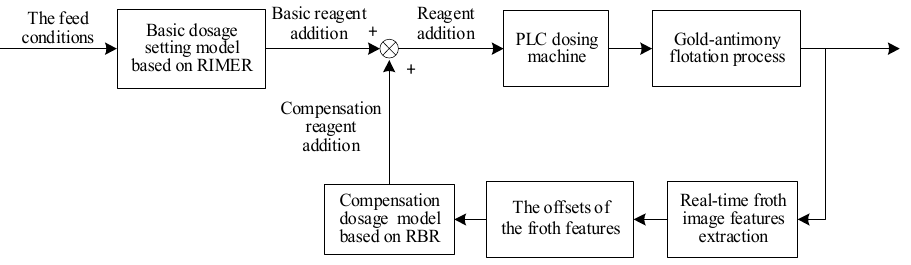
Figure 2. Reagent addition optimal-setting control strategy for gold-antimony flotation process.